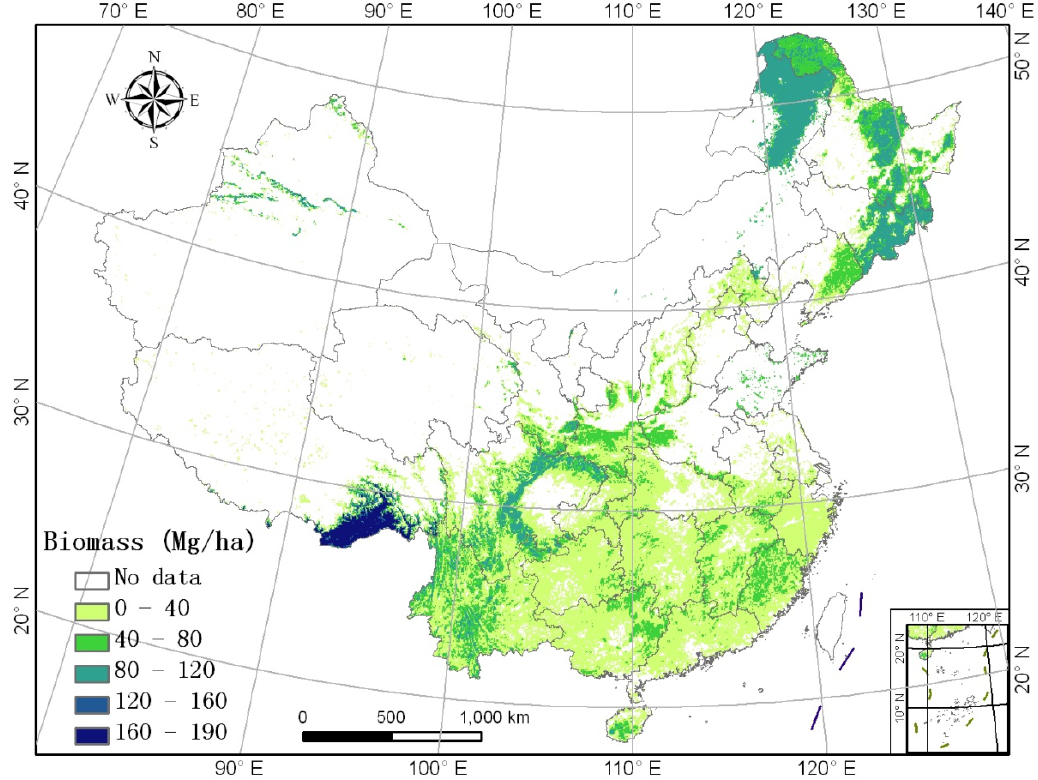
Figure 6. Spatial distribution of forest biomass in China for the period